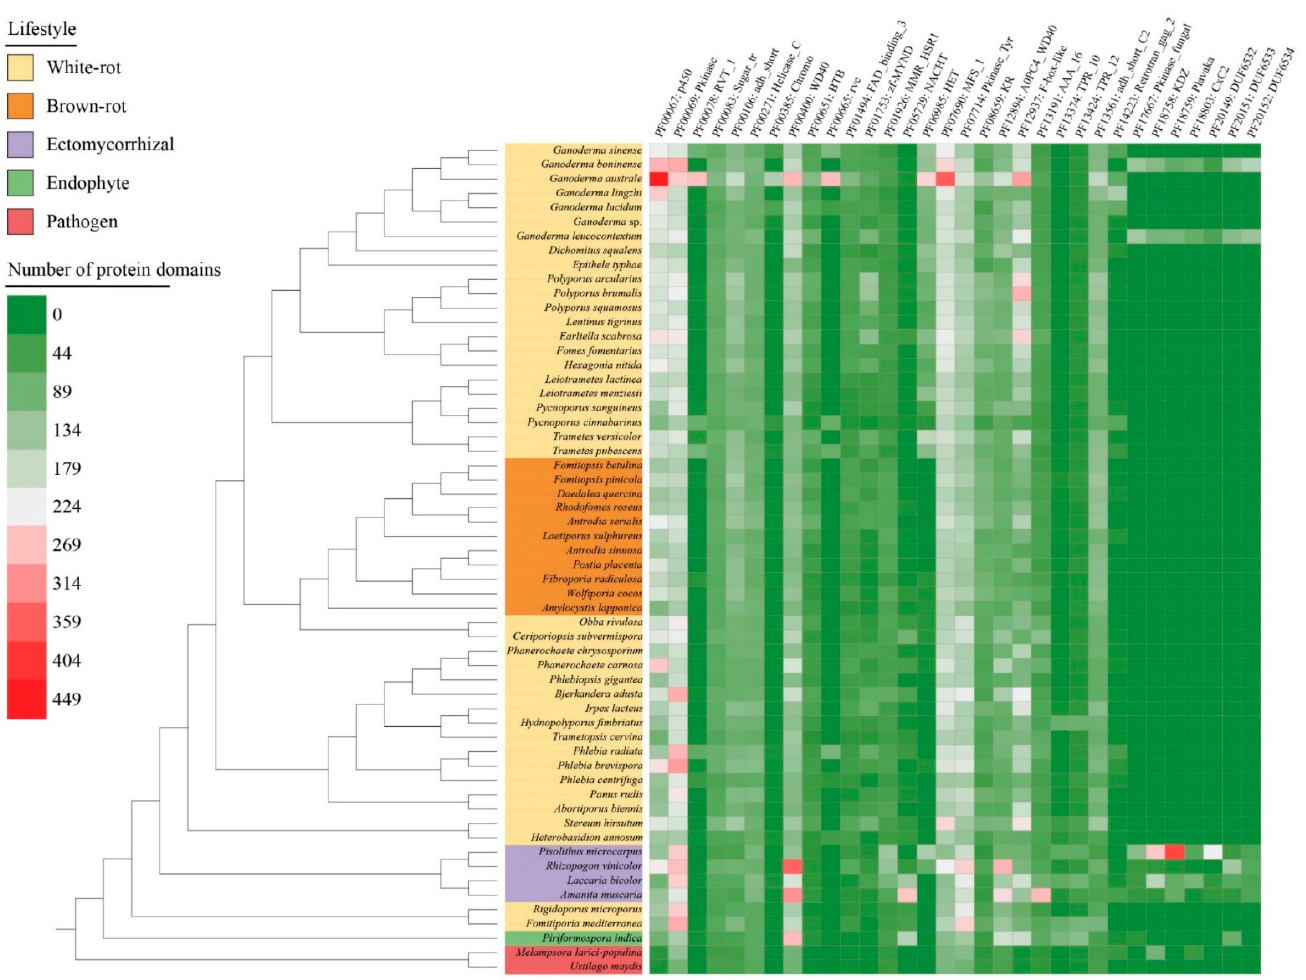
Figure 6. Distribution and abundance of the top 100 Pfam protein domains in the selected 58 species. The heatmap depicts the protein domain copy number according to the color scale from purple to green. Color codes for the five fungal lifestyles are shown at the top left of the figure.